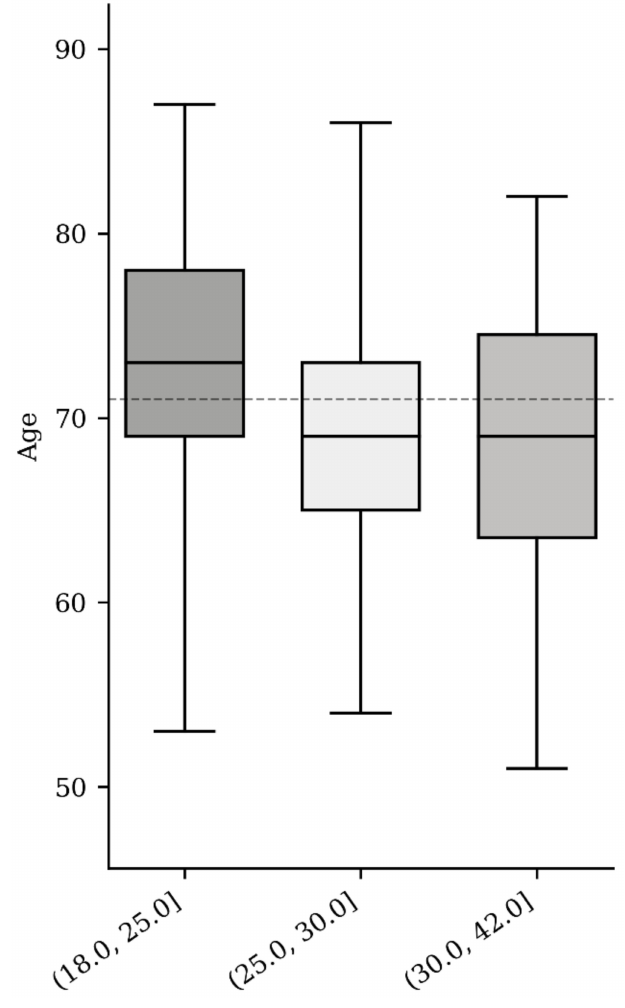
Figure 2. BMI based on